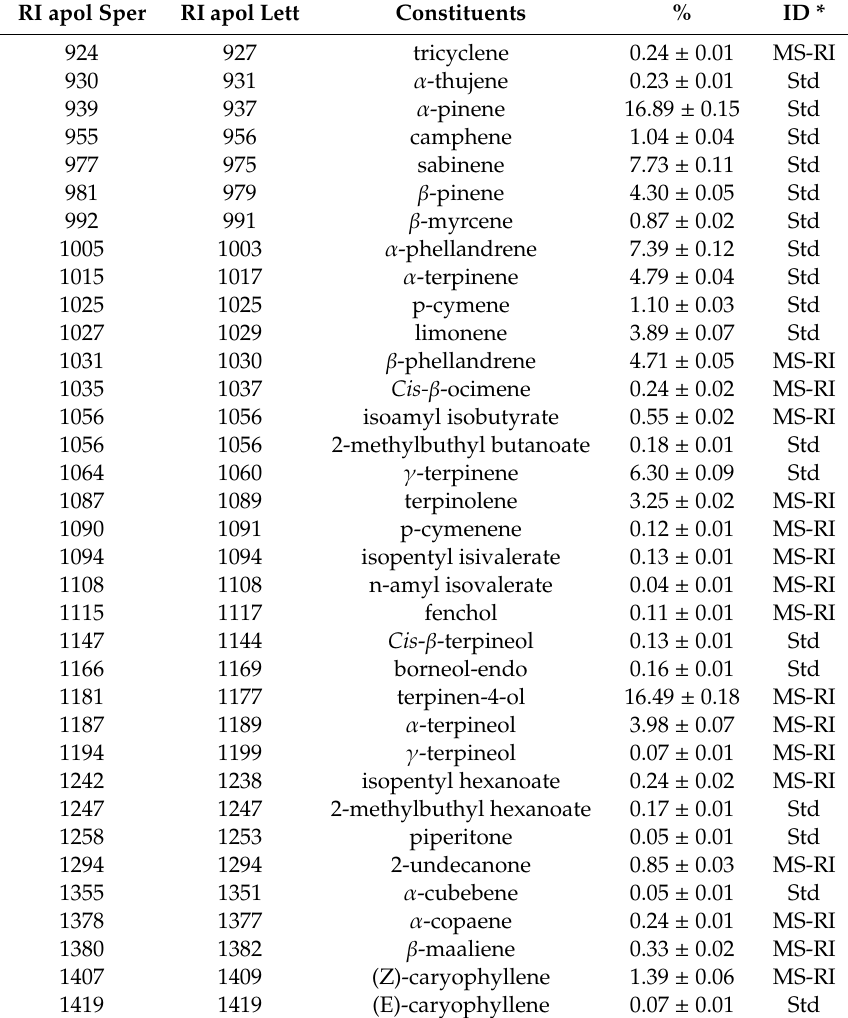
Table 1. Chemical composition of Pistacia lentiscus L. essential oil from fresh leaves. RI apol Sper RI apol